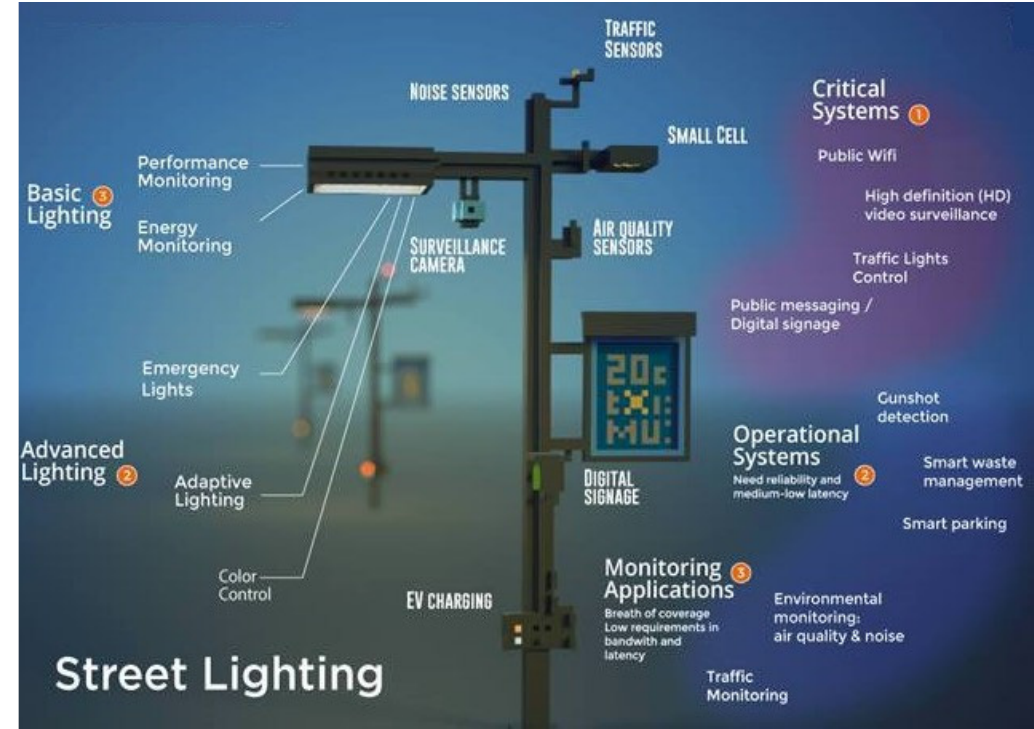
Figure 3. Smart Street Lighting as a Smart City Platform [94].